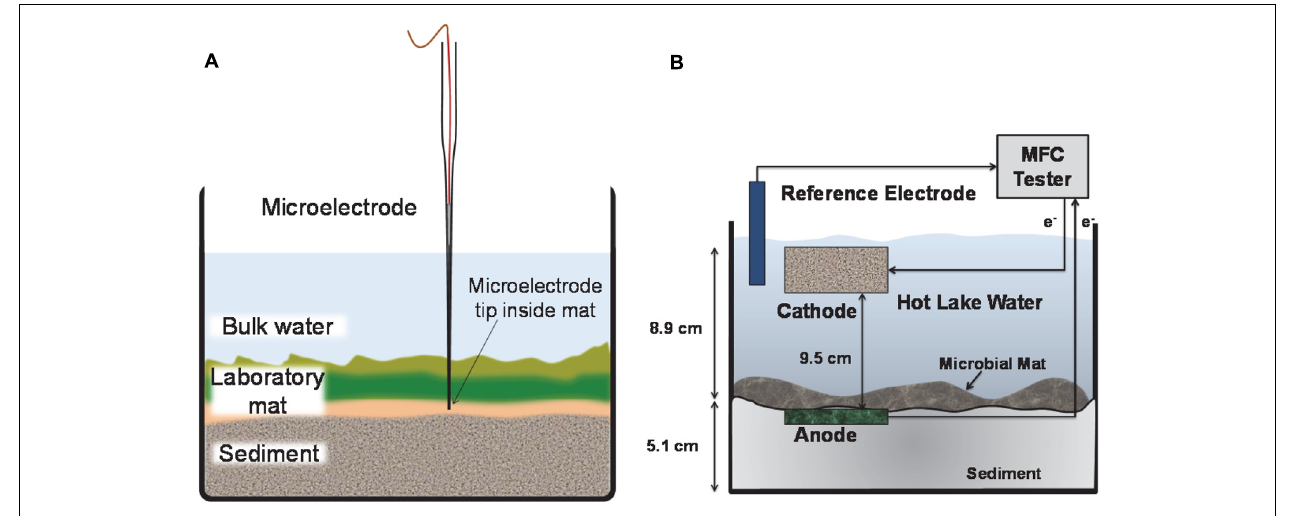
FIGURE 2 | Side view of laboratory mat incubation experiments. (A) The microelectrode tip was positioned at depth inside the mat.The microelectrode was continuously polarized anodically against a Ag/AgCl